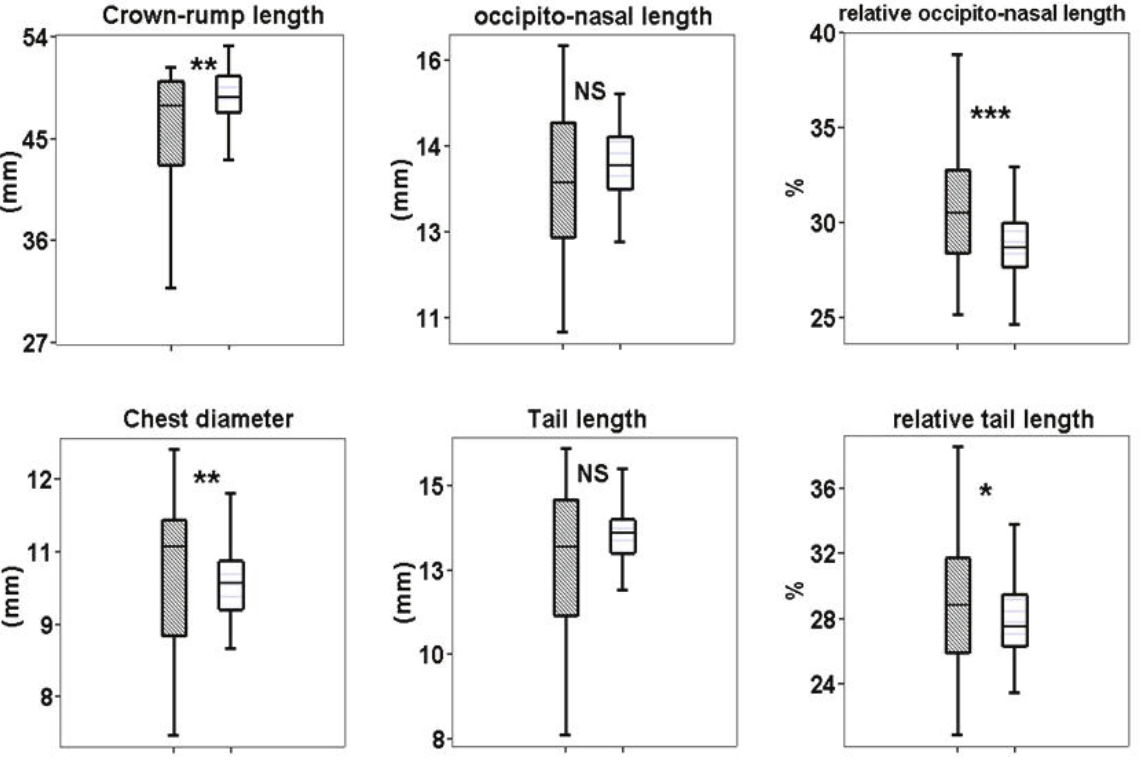
Figure 2. External body sizes of fetuses from pregnant rats treated with a daily dose of 300 µg/kg of Buthus occitanus tunetanus venom (striped boxes) or 1 mL/kg of saline solution (white boxes), from the 7 th to the 13 th day of gestation ( median, 25%-75%,